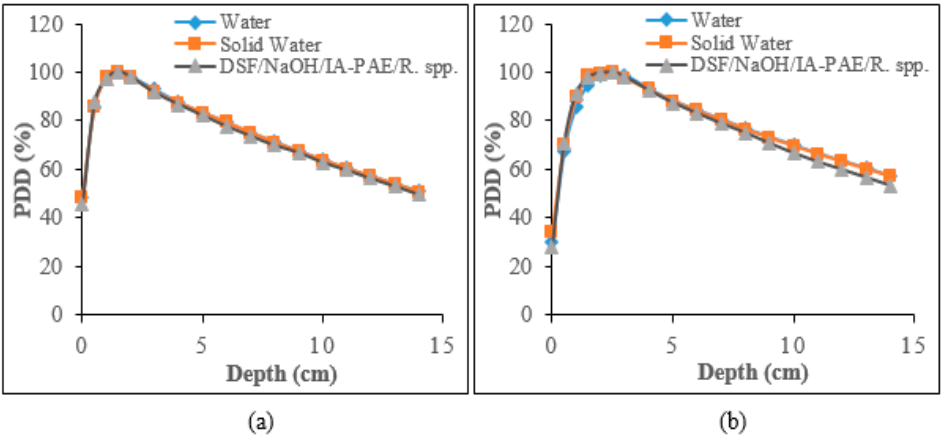
Figure 6. PDD curves for water, solid water, and DSF/NaOH/IA-PAE/ R. spp. particleboard phantoms using IC for: ( a ) 6 MV and ( b ) 10 MV photons.